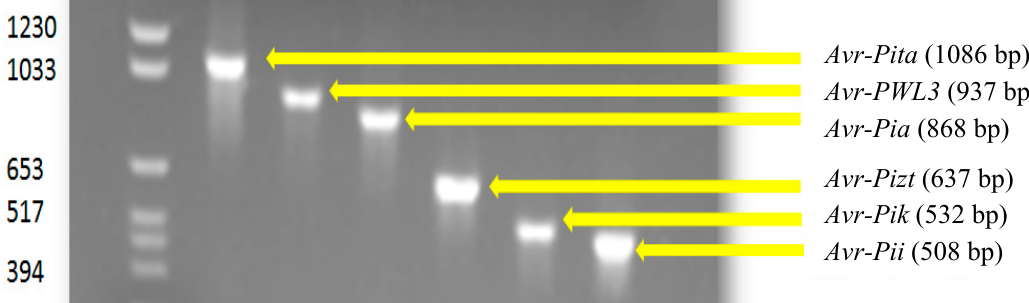
Figure 2. Agarose gel electrophoresis of PCR products from M . oryzae isolates tested for a specific avirulence gene.